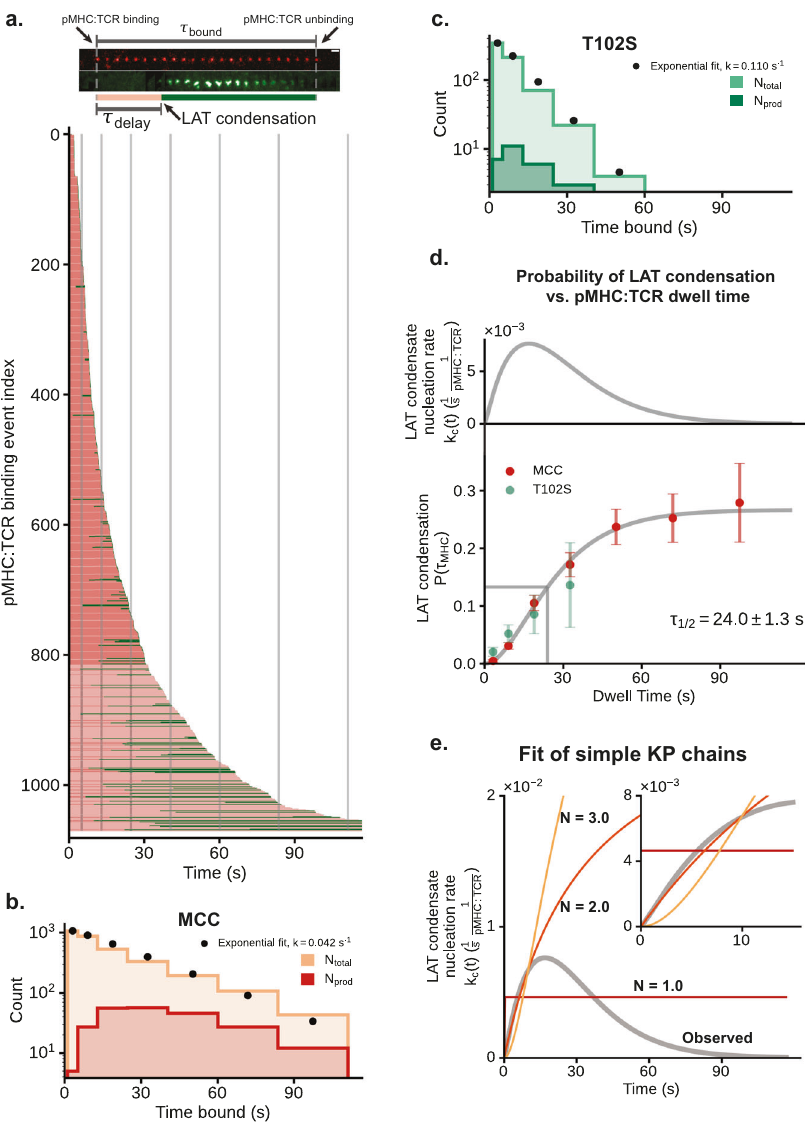
Fig. 3 | pMHC:TCR binding dwell time modulates probability of LAT con- segments(green)foraparticulartimebinwastheofnumberbindingeventswithin densateformation.a Top:timeseriesimagesillustratingthetemporalpartitioning thatdwell timewindow whichhadatsome prior time producedaLATcondensate. of the total pMHC:TCR dwell time into a delay time (pink) and a remaining pro- The total population of dwell time segments (aquamarine) was fi t with an expo- .The fi tdistributionwasintegratedfor ductive dwell time (green). Bottom: A bar plot of a collection of 1071 pMHC:TCR nentialdecayrateof k obs = k off + k bleach = 1 9 : 1s each bin and plotted as a black circle. d Bottom: The probability of a pMHC:TCR binding events from 12 cells across 3 mice. Each bar represents a fully tracked bindingeventproducingalocalizedLATcondensateasafunctionofdwelltime.For pMHC:TCRbindingevent.Themomentofcondensation(ifany)isindicatedbythe each bin of the histograms in panels b and c , the fraction of dwell time segments bar transitioning from pink (unproductive dwell time) to green (productive dwell that were productive is plotted as a point. The error bars were computed as the time).The graylines demarcate the bins usedin the histograms for panels b and c . standard error of the mean for a binomial variable ( n , the total number of binding For b and c : Linearly increasing bin widths wereused to improve the sampling rate events in the bin, and p the productive fraction). The interpolating gray line was a of rare long-binding events. b MCC pMHC dwell time segments were aggregated fi tted regularized gamma function with a maximal amplitude parameter. Top: The according to the indicated bin widths. The number of productive dwell time seg- effective rate ofLATproduction k c t ð Þ , whichis derived from the grayinterpolating ments (red) for a particular time bin was the number of binding events within that line inthe bottom panel, is plotted along thesame time axis. e Nucleation rates for dwelltime window whichhadatsome priortime produced a LATcondensate. The various hypothetical simple kinetic proofreading schemes ( N =1, 2, or 3 steps) are totalpopulationofdwelltimesegments(orange)was fi twithanexponentialdecay .The fi tdistributionwasintegratedforea c hbinand plotted to illustrate key differences compared with the observed effective rateof k obs = k off + k bleach = 1 23 : 8s plotted as a black circle. c T102S pMHC dwell time segments were aggregated nucleation rate (see “ k c ð t Þ as a propensity function ” in Methods for more details). Source data are provided as a Source data fi according to the indicated bin widths. The number of productive dwell time